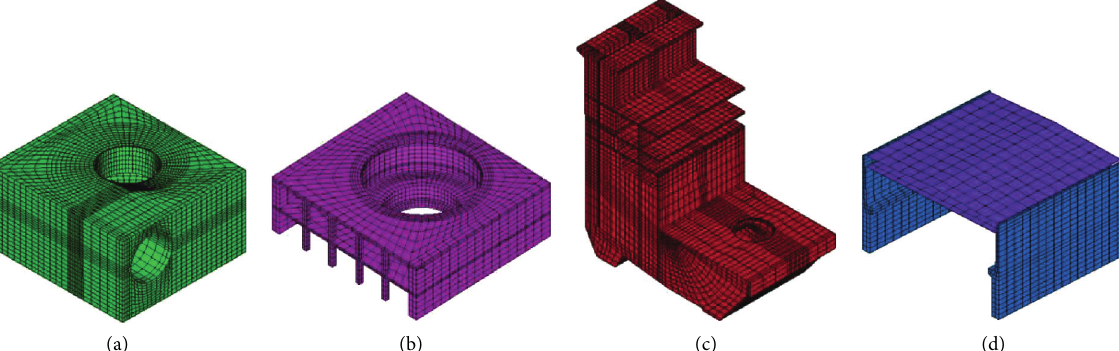
Figure 4: 3D structured grids for the concrete domain. (a) Turbine floor. (b) Dynamo floor. (c) Draft tube block structure. (d) Sidewall and roof.